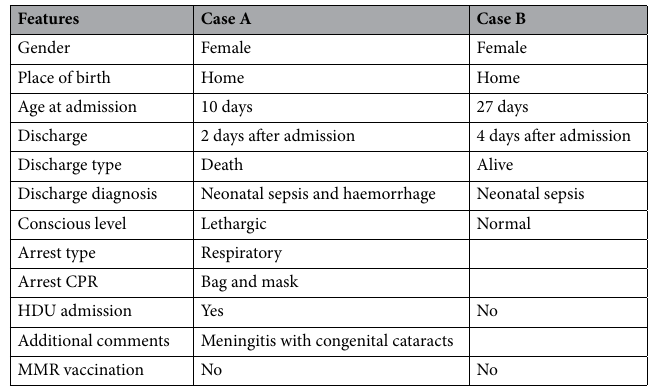
Table 2. Infection features of two rubella cases. CPR cardiopulmonary resuscitation, HDU high dependency